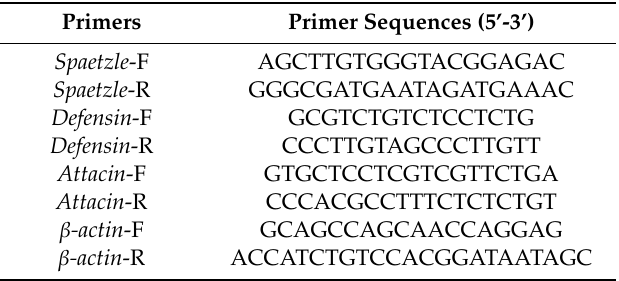
Table 1. PCR primers used in this